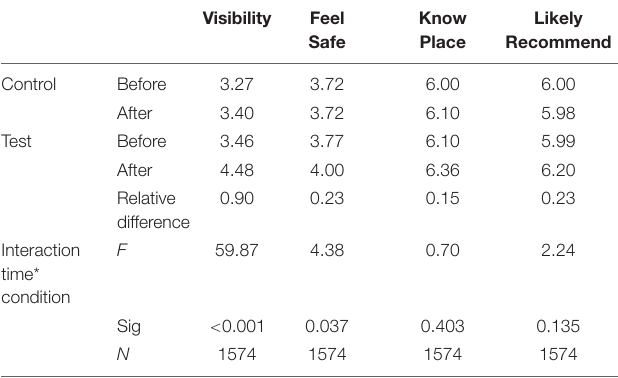
TABLE 4 | Perceptions about cycling in the street, before and after for test and control